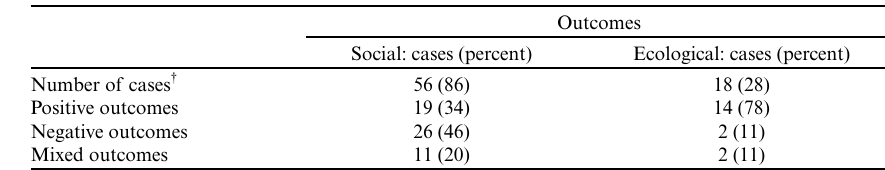
Table 1 . Total number and percent of cases that addressed social and ecological outcomes of community-based conservation ( n = 65), and the relative proportion of cases that reported positive, negative, and mixed social and ecological outcomes. Percent for the positive, negative, and mixed outcomes is proportional to the total number of cases for social and ecological outcomes respectively, not the total sample.